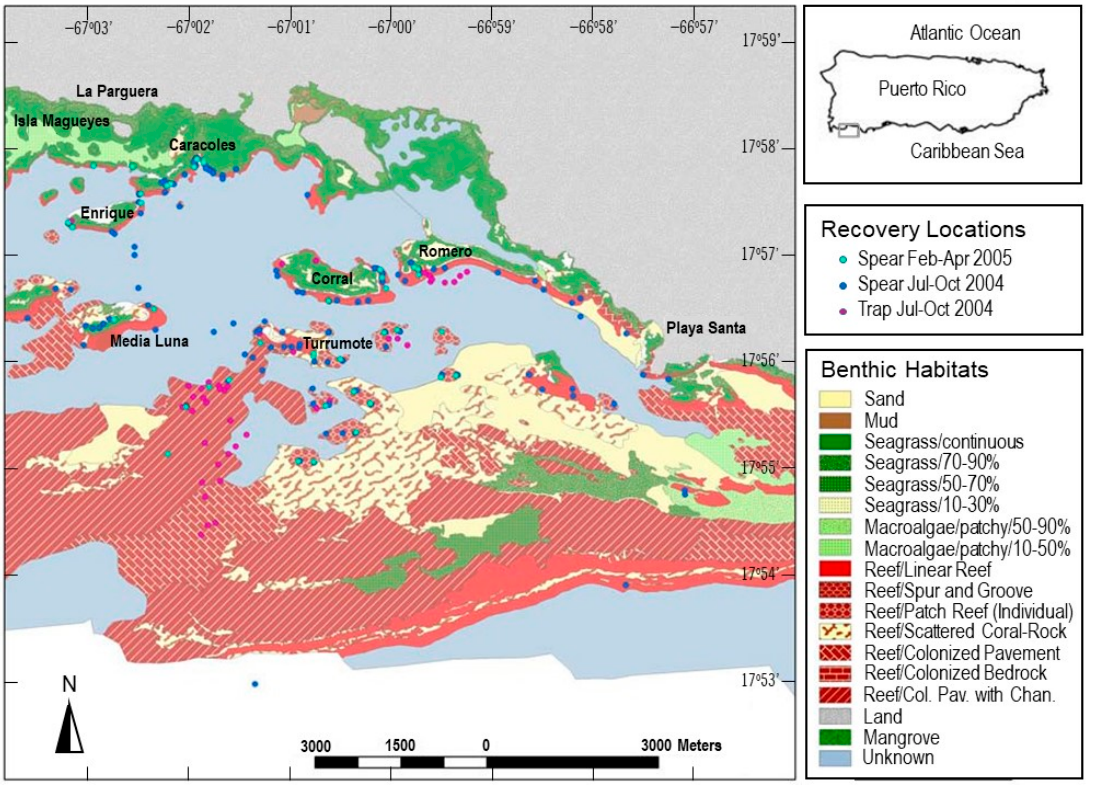
Figure 1. Habitat map of the study area off La Parguera, Puerto Rico (from Kendall et al. [37]). Circles indicate locations for attempted recapture by spearing and trapping of Haemulon flavolineatum .